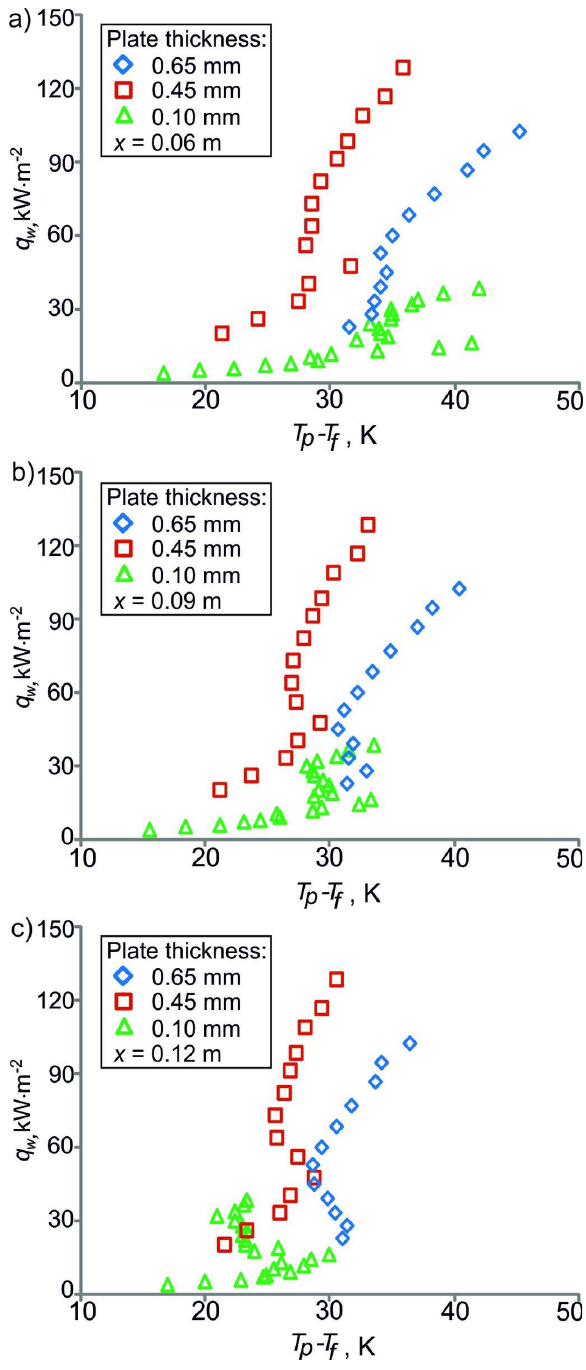
Fig. 8. Boiling curves generated for the three distances from the minichannel inlet: 0.06 m (a), 0.09 m (b) and 0.12 m (c) constructed as: q w vs. T p - T f , T p - heated plate temperature, T f - bulk fluid